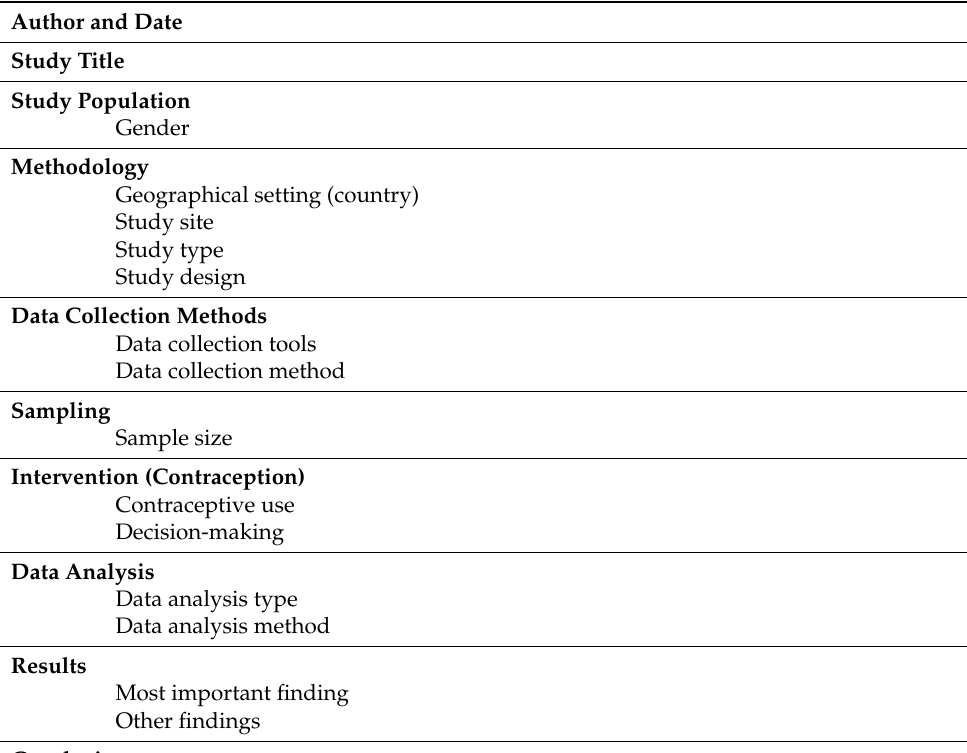
Table 2. Data extraction